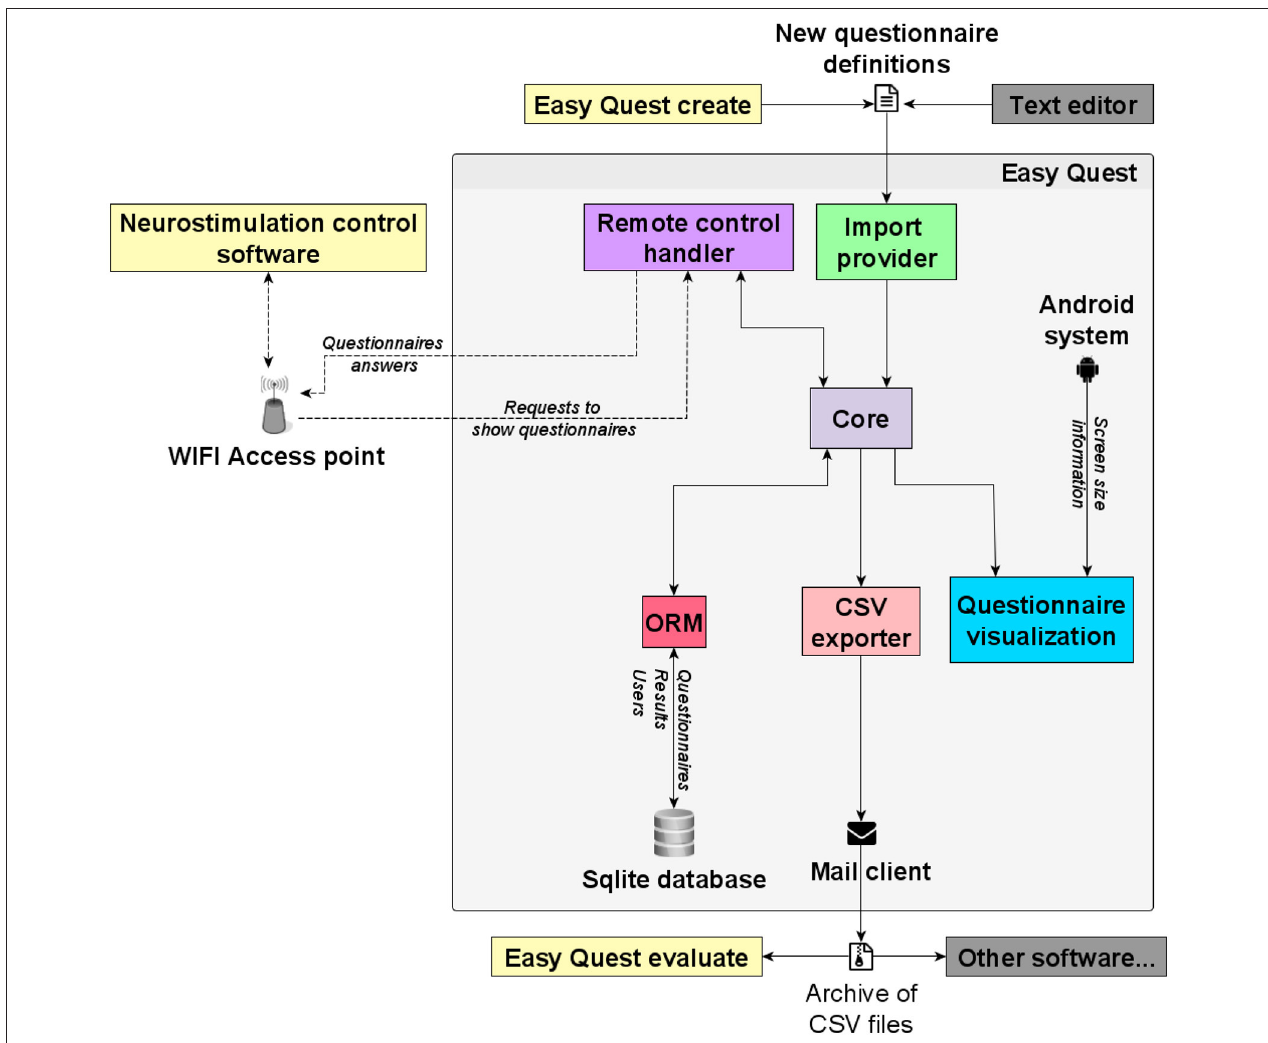
FIGURE 4 | Software architecture. The main components of the platform depicted as squares, external services are shown with an icon and communication with arrows, some show a label with examples of the information flowing through. A gray shadow surrounds the software modules of the mobile app (Easy